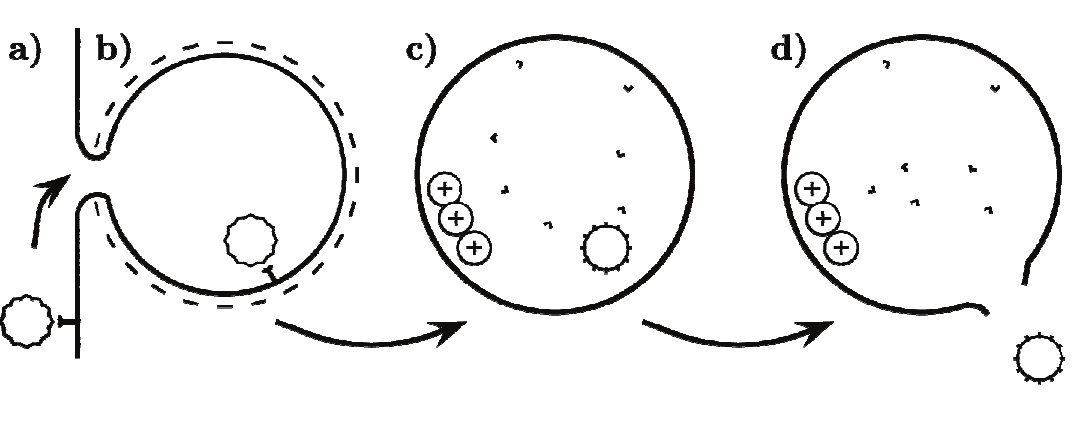
Figure 2. Scheme of early stages of parvovirus infection. The parvovirus particle interacts with a receptor and becomes internalized using clathrin-coated pit ( a , b ), where pH decreases (+, protons) and capsid proteins undergo conformational changes, N-terminus of VP2 may be cleaved, N-terminus of VP1 is exposed on the capsid surface ( c ). The parvovirus leaves the endosome by a yet undefined mechanism ( d